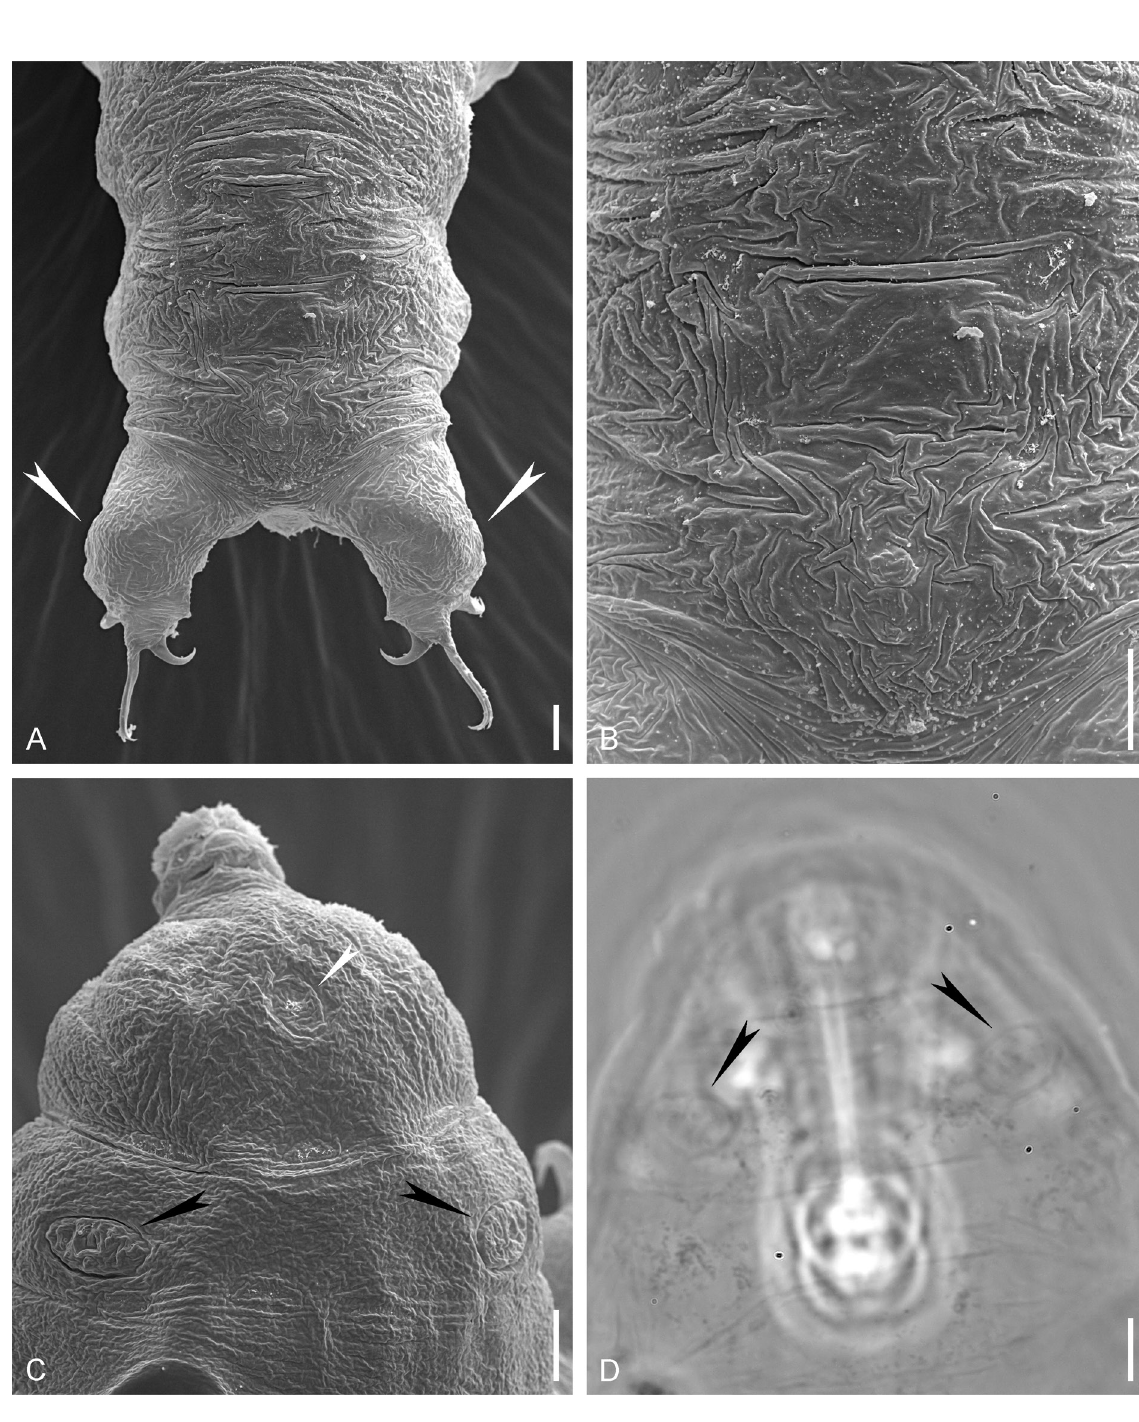
Fig. 3. Hypsibius pallidoides Pilato, Kiosya, Lisi, Inshina & Biserov, 2011. A . Dorsal view of the caudal body end, white arrowheads indicate the dorsal inflations of the hind legs, SEM. B . Dorsal sculpture of the caudal body region, SEm. C . Dorsal surface of the head region, black arrowheads indicate the elliptical sensory organs, white arrowhead indicates the central concavity on the dorsal surface of the head, SEm. D . Dorsal surface of the head region, black arrowheads indicate the elliptical sensory organs (SPbu 251(89)), PhC. Scale bars = 5